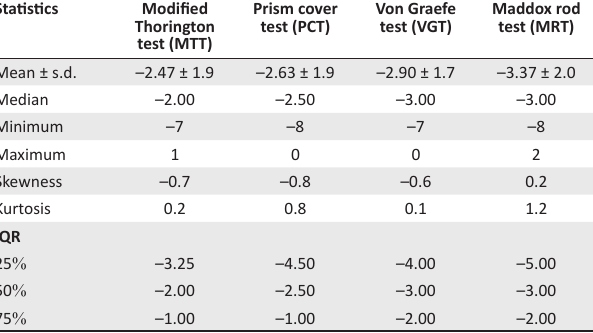
TABLE 2: Descriptive statistics for the four near heterophoria methods.